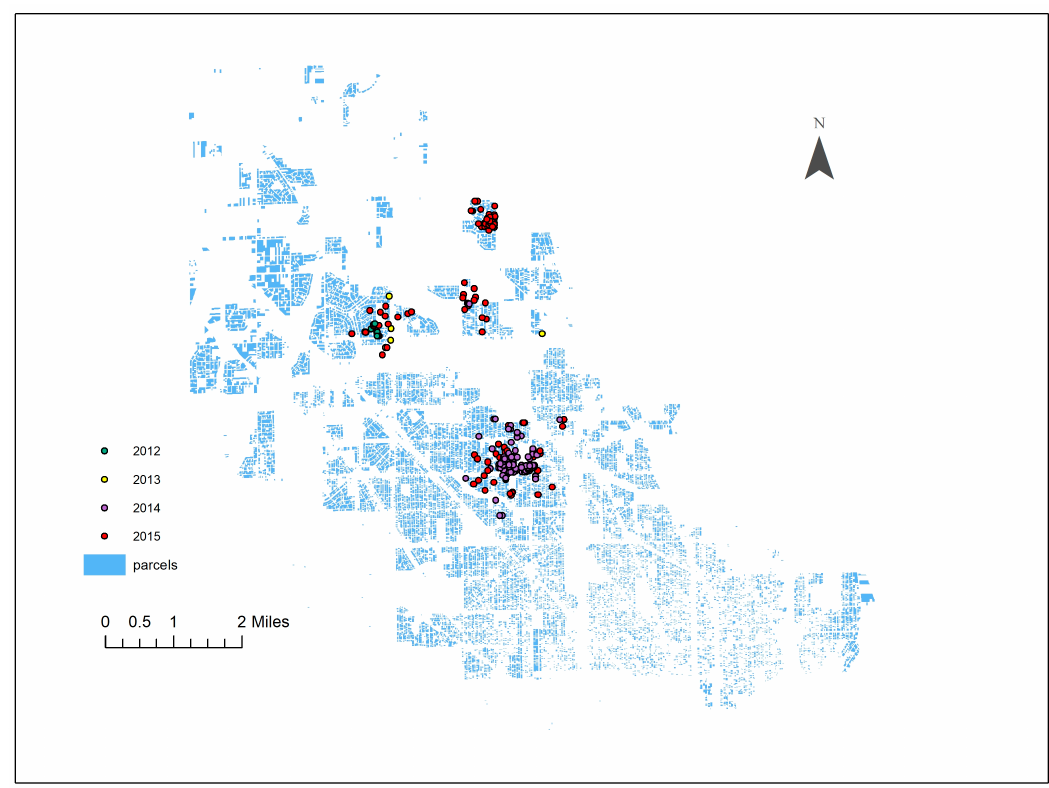
Figure 2. Distribution of emerald ash borer (EAB) infestation from 2012 to 2015 in our study area (northern part of Milwaukee).